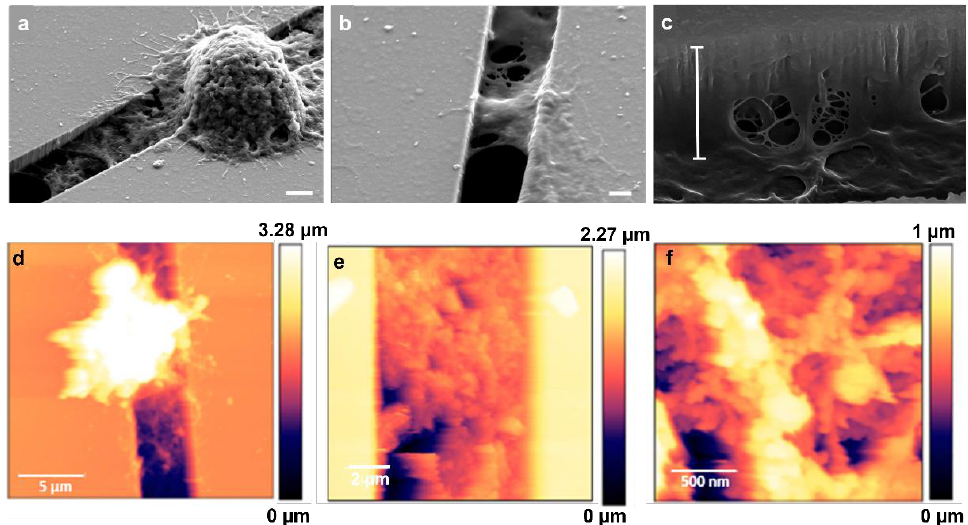
Figure 10. ( a ) SEM images of matrix residues under MDA-MB-231 cells adhering to a 4 µm wide gap (scale bar 2 µm); ( b ) SEM image of matrix residues on the 2 µm wide gap (scale bar: 1 µm); ( c ) SEM image with tilted view of matrix deposited inside the gaps — the measured depth of residues (white bar) is 1.8 µm (scale bar: 100 nm); ( d ) AFM image (scan: 20 µm × 20 µm) of the structures deposited on the micro- gaps (2 μm wide) by the MDA -MB-231 cells after 24 h of migration; ( e , f ) AFM images performed on a magnified image of the layer deposited in the gap (scans: 10 µm × 10 µm and 2 µm × 2 µm, respectively) taken across the micro- gaps (2 μm wide).